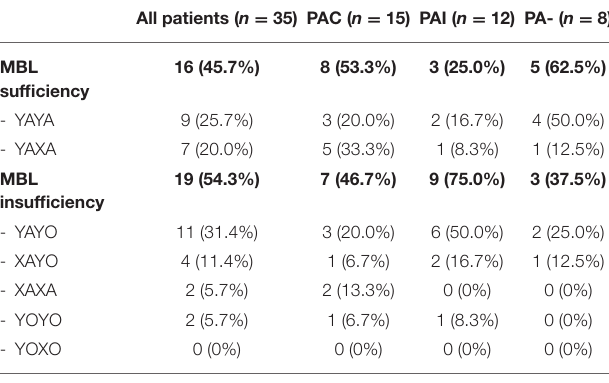
TABLE 3 | Distribution of MBL2 haplotypes and expression groups in CF